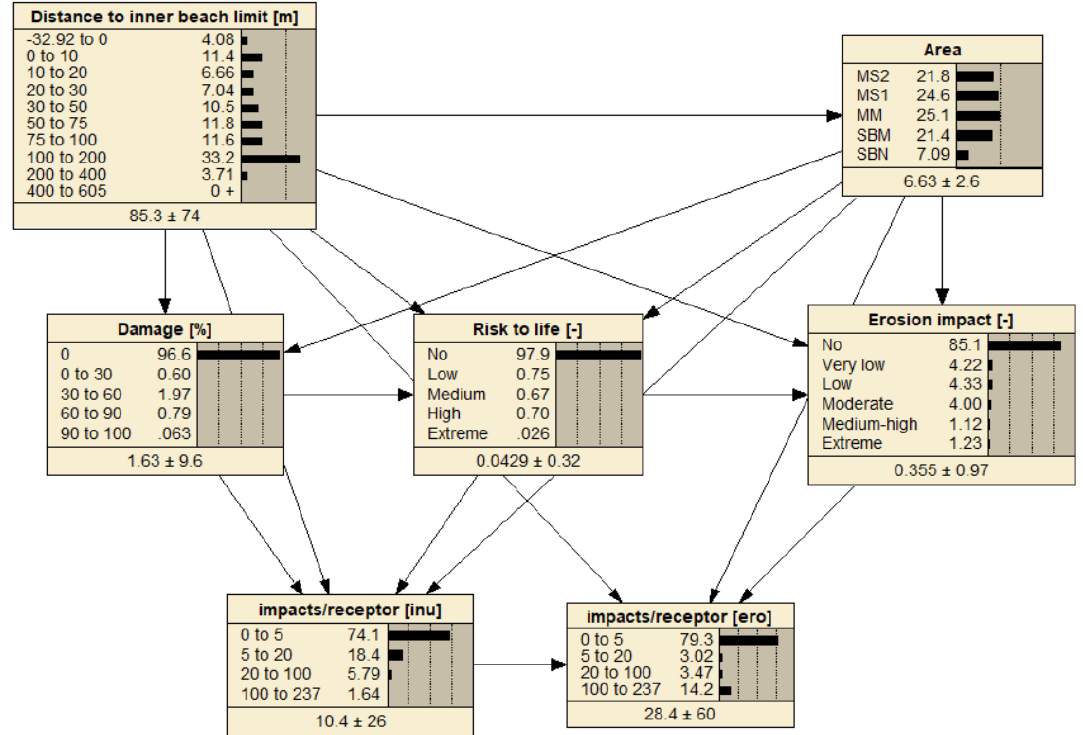
Figure 7. BN-B, linking consequences to receptors spatial locations. Distributions correspond to the baseline scenario.